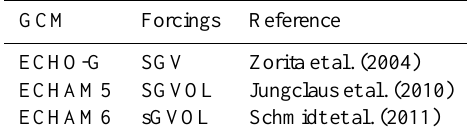
Table 2. Overview of the GCM forcings. The forcings are abbre- viated as follows: S – strong solar forcing ( > 0 . 2% change since LMM); s – weak solar forcing ( < 0 . 1% change since LMM); G – greenhouse gas; V – volcanic; O – orbital; L – land-use change. The last column gives the references describing the